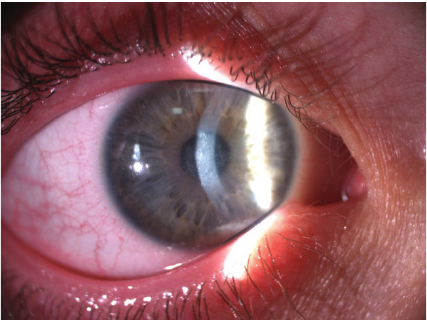
Figure 4: Biomicroscopy of cornea at the end of first month revealing complete resolution of